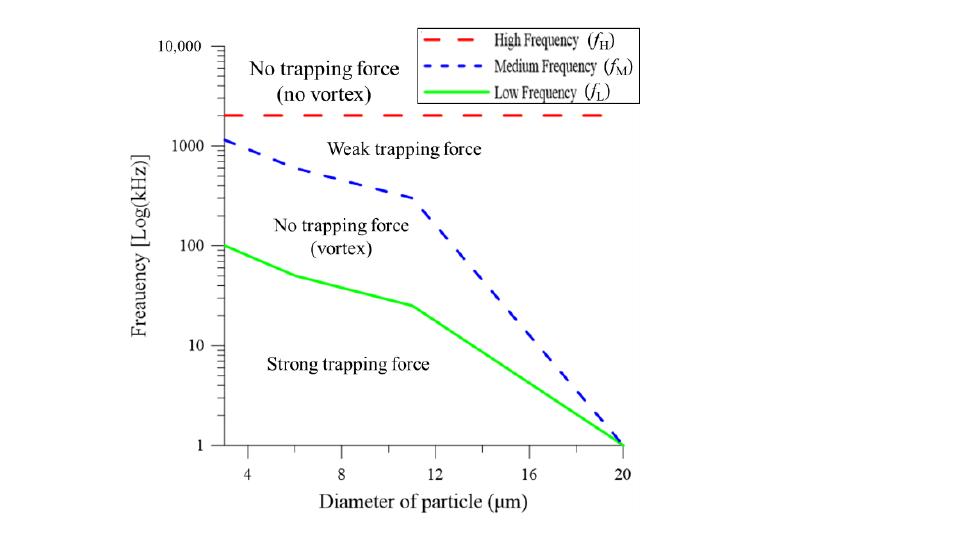
Figure 7. Optoelectrokinetic trapping behavior of particles as function of driving frequency and particle size.